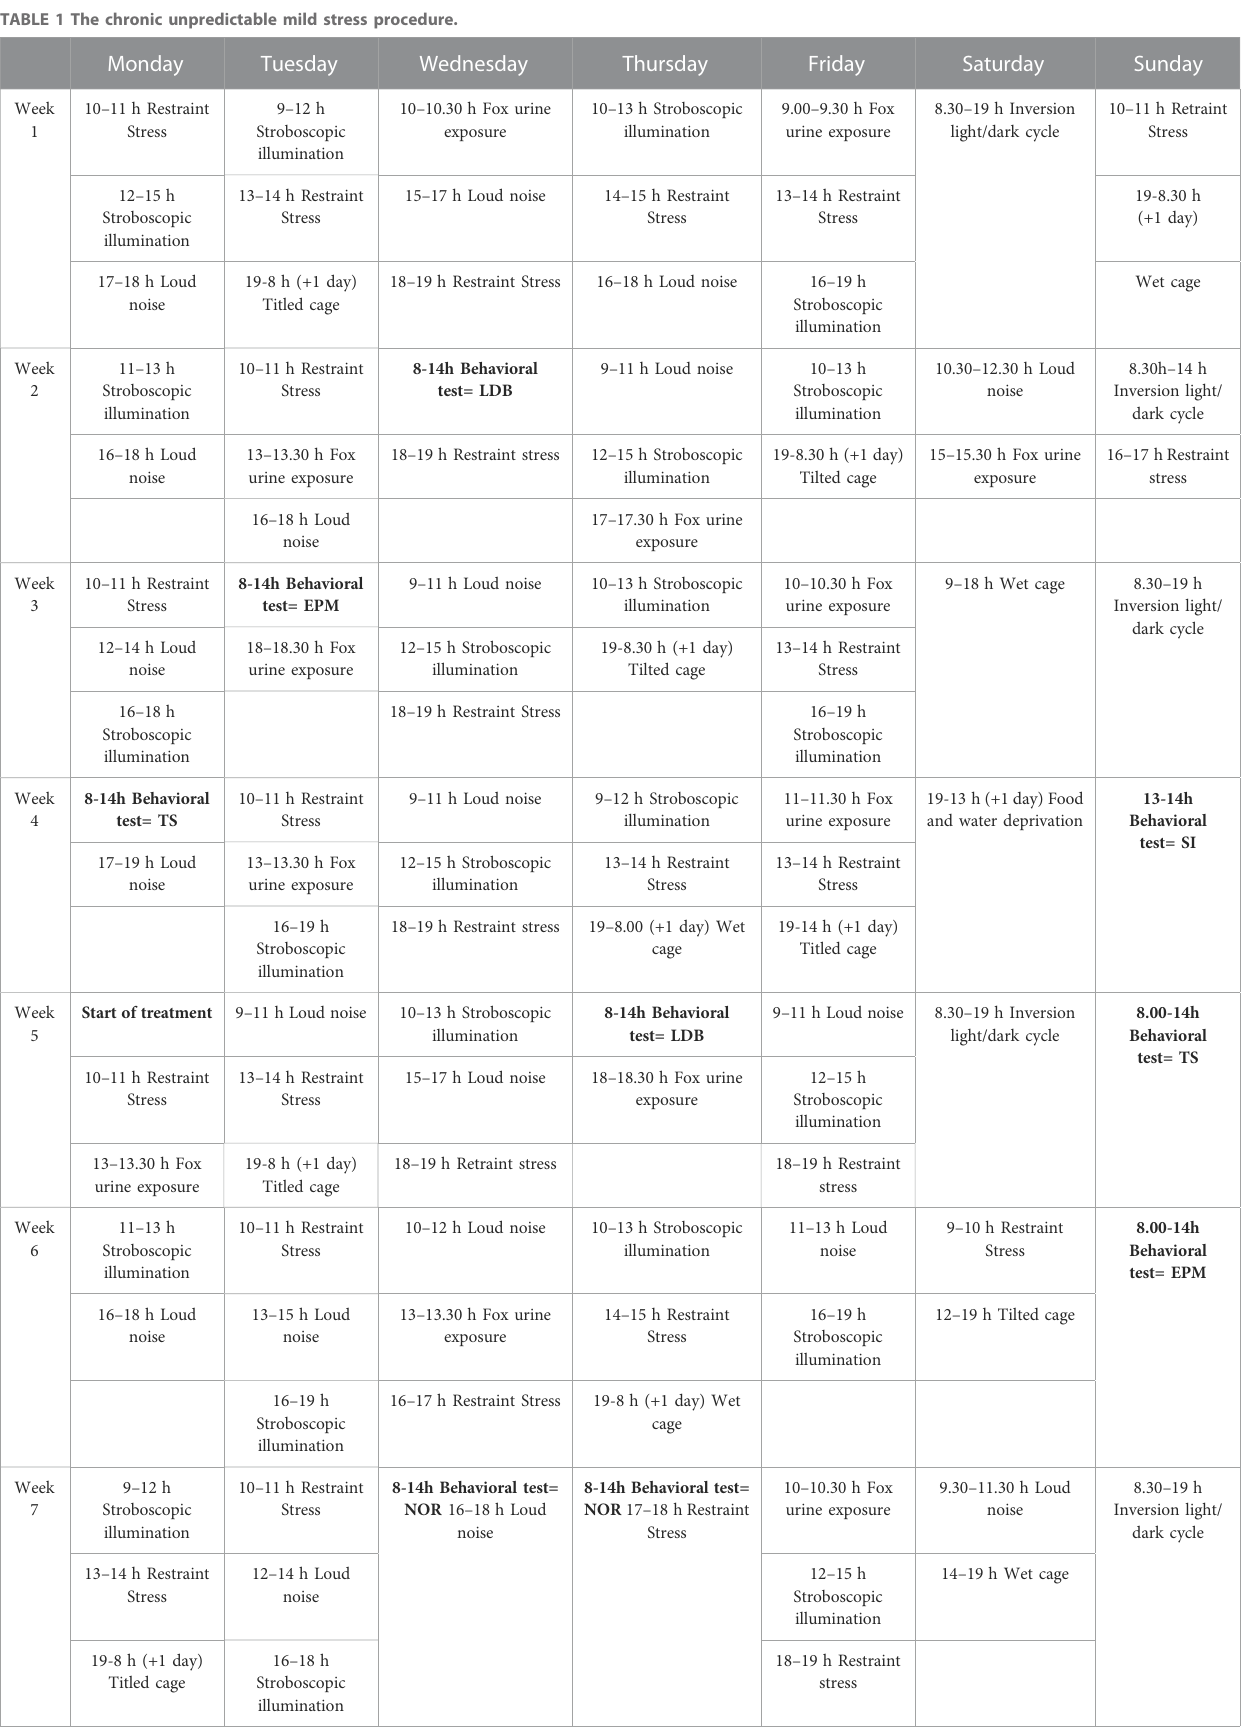
TABLE 1 The chronic unpredictable mild stress